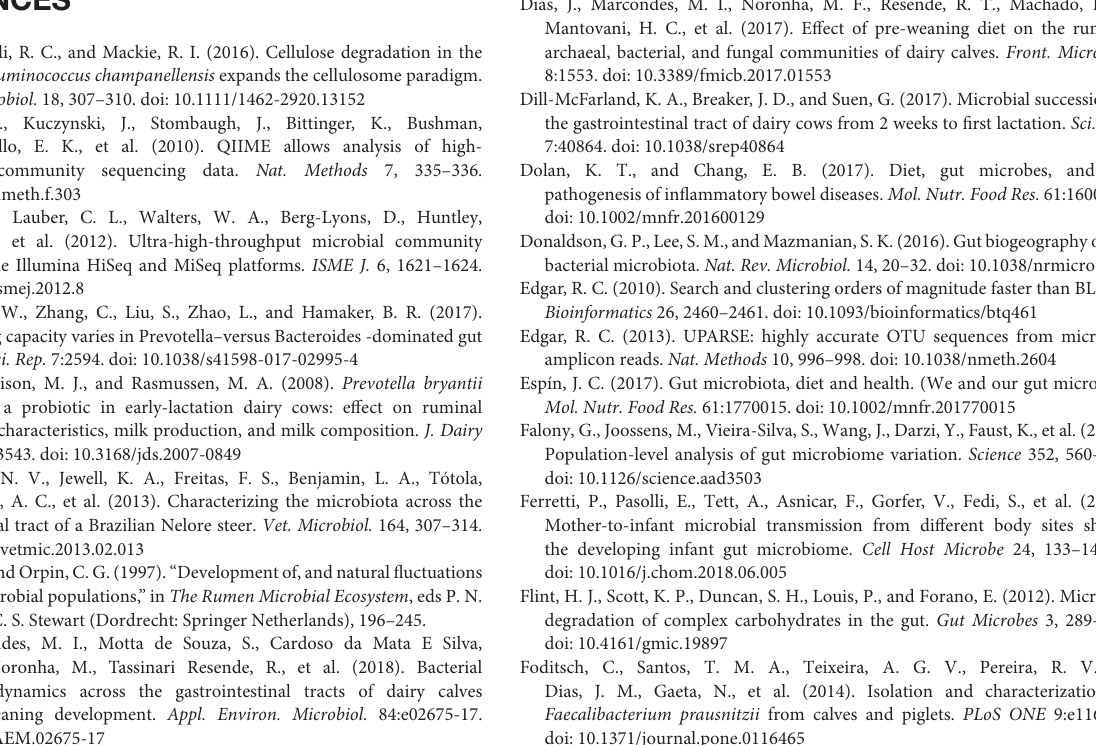
Figure S1 | Summary of rarefaction results based on operational taxonomic unit (OTUs) (3% divergence) for each sample. Figure S2 | Bacterial composition in samples of rumen, duodenum, jejunum, ileum, cecum, and colon at different ages (at the phylum level). Figure S3 | Bacterial composition along the gastrointestinal tract at different ages (at the genus level). Figure S4 | Alpha diversity of the bacterial community between gastrointestinal tract (GIT) regions in each age group. The richness and diversity were calculated via Chao (A) and Shannon (B) indexes, respectively. Boxplots indicate significant differences among GIT region in a given age group. Figure S5 | Bacterial composition in different gastrointestinal tract compartments and comparison of predominant taxa. (A) Bacterial composition among different GIT compartments in each age group. (B) Comparison of relative abundances of the main bacterial phyla (Firmicutes, Bacteroidetes, and Proteobacteria) among different GIT compartments in each age group. Bars with a star symbol above their whiskers are significantly different between age groups in each GIT compartment using a one-way ANOVA analysis; ∗ 0.01 < P < 0.05; ∗∗ 0.001 < P < 0.01; ∗∗∗ P < 0.001. Table S1 | Ingredients and nutrients of the experimental diets. Table S2 | Number of sequences, operational taxonomic unit (OTU), richness, diversity, and estimated sample coverage of each sample. Table S3 | Alpha diversity of bacterial community according to ages in each gastrointestinal tract (GIT) region. Mean values with different superscripted